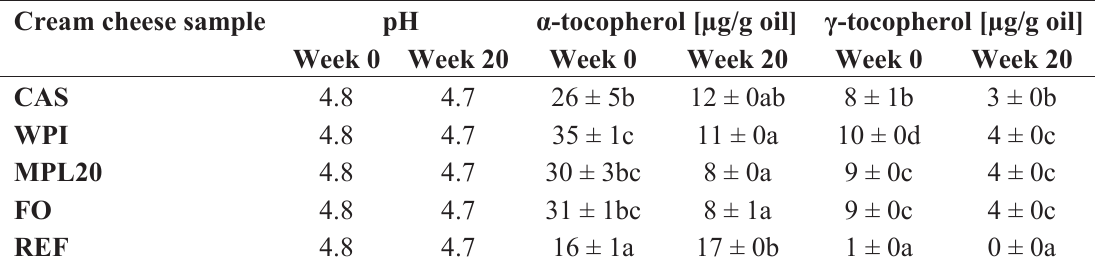
Table 3. pH and tocopherol contents in cream cheeses at week 0 and week 20 of storage. Letters indicate significant differences ( P < 0.05).